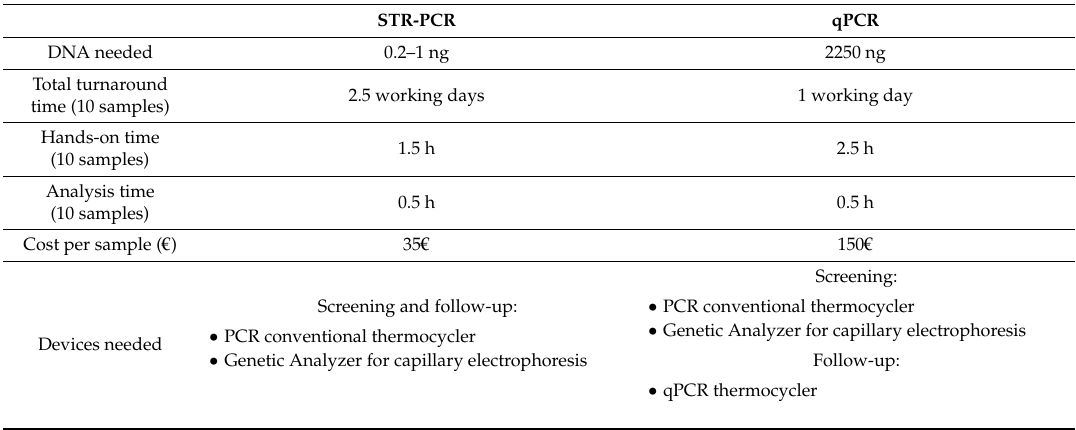
Table 3. Assessment of consumables, cost per sample and process duration of STR-PCR and